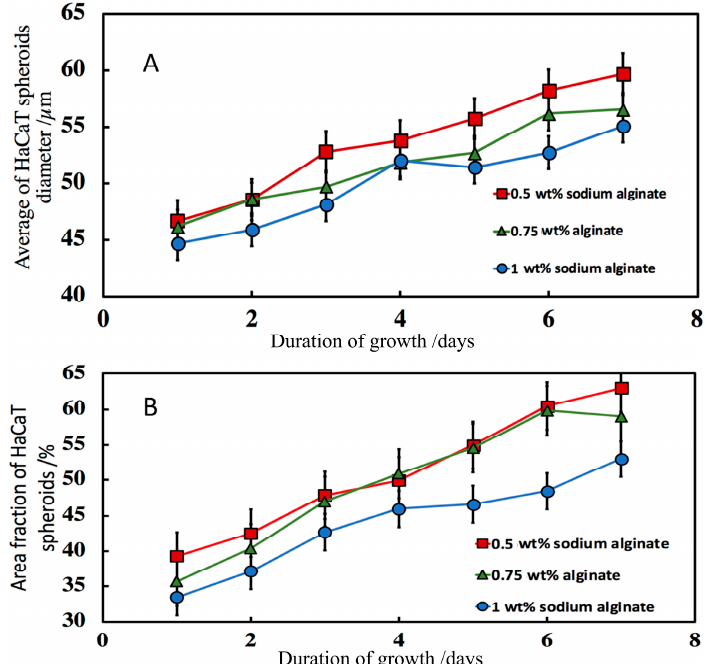
Figure 9. Evolution of the HaCaT clusteroids embedded in a hydrogel composed by different concentrations of sodium alginate and DMEM media for seven days. ( A ) The average spheroid size vs. time and ( B ) fractional area of the clusteroids in the alginate film vs. time. Measurements of the clusteroids were made every day with ImageJ software by taking the average of the vertical and horizontal diameter of 500 clusteroids in each well. The area fraction at 0.5 wt% and 0.75 wt% were both significantly different from the area fraction at 1% ( p < 0.05).